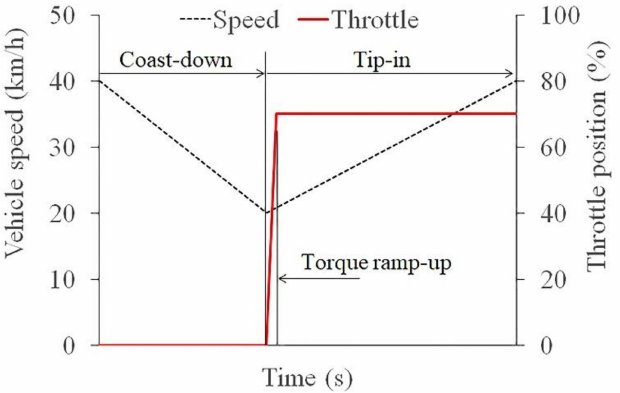
Figure 5. Tip-in test event for REEV driveability analysis at 70% throttle position. Table 4. Three road mu values for driveability analysis of REEV. Road Surfaces Right